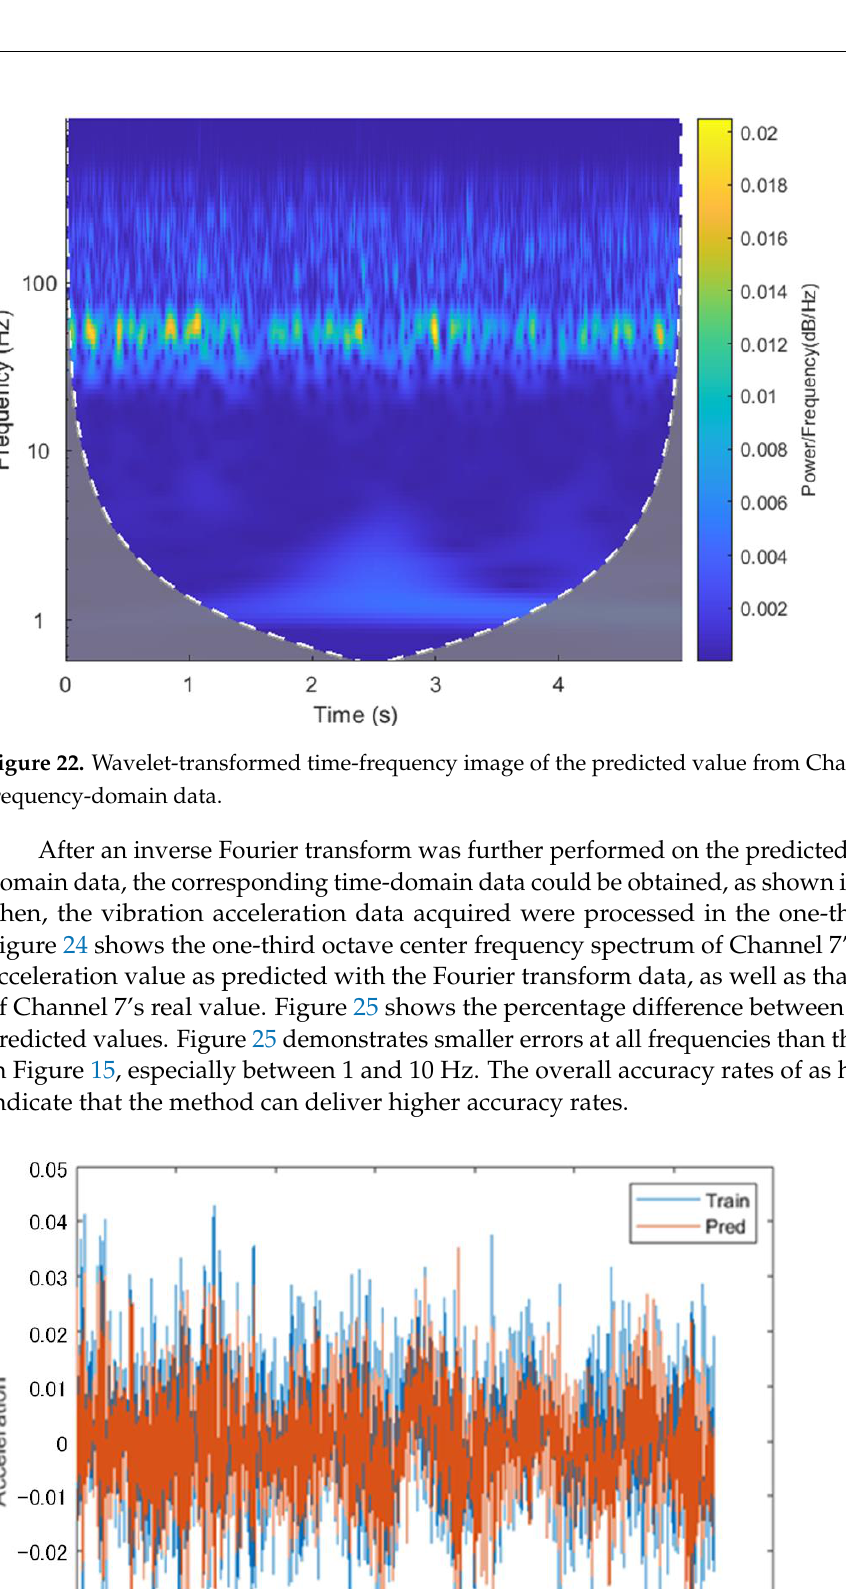
Figure 21. Wavelet-transformed time-frequency image of the measured value from Channel 7 us- ing frequency-domain data.